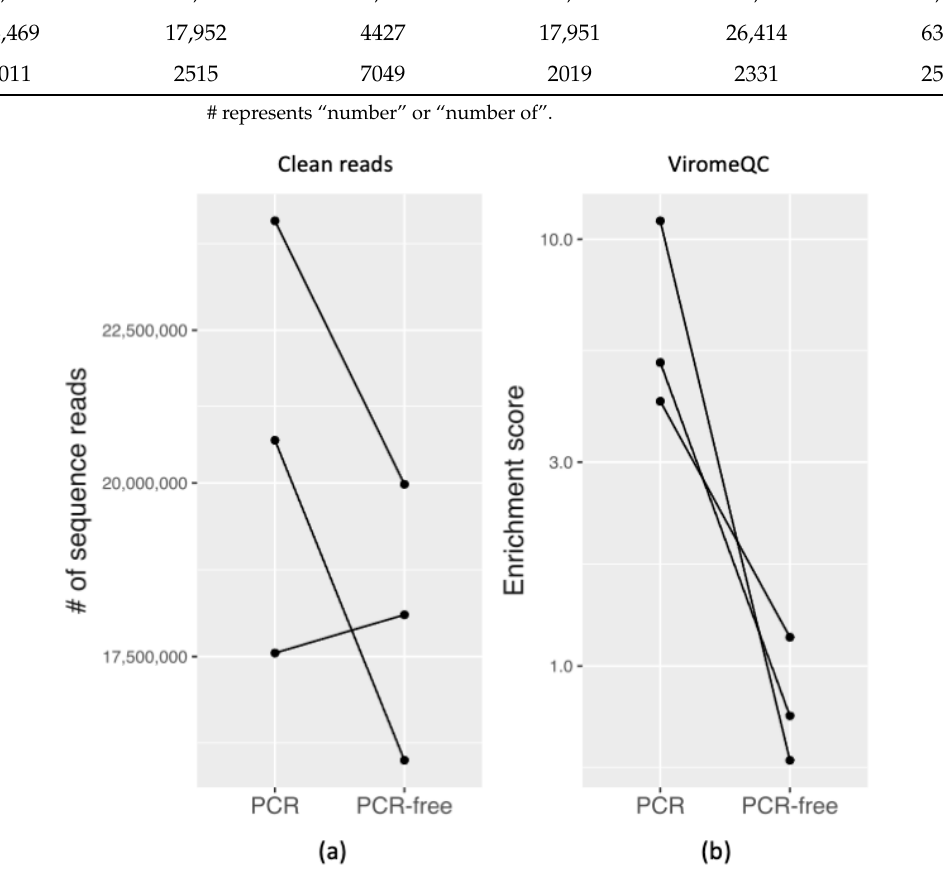
Figure 3. Quantity of cleaned reads and the measurement of VLP enrichment. The plots show the trends between the PCR and PCR-free groups. ( a ) The total cleaned sequence reads show that for samples 2 and 3 more reads were obtained from PCR compared to PCR-free samples, with insufficient evidence to detect an average effect on the number of reads (paired t -test p -value = 0.234). ( b ) From the ViromeQC analysis, the enrichment score was noticeably higher in PCR samples, on a log scale. However, the paired t -test on the log scale values were not statistically significant ( t -test p -value = 0.05123). # represents “number”.